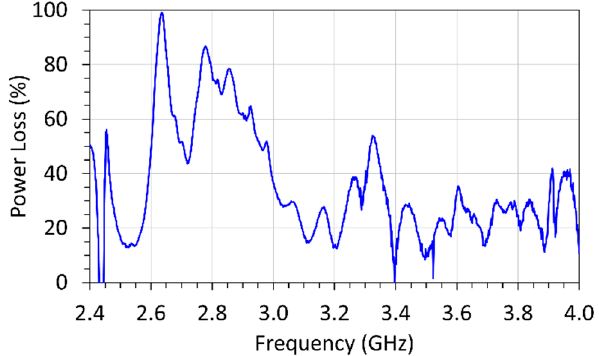
Figure 12. Power loss frequency response for the deembedded DUT.